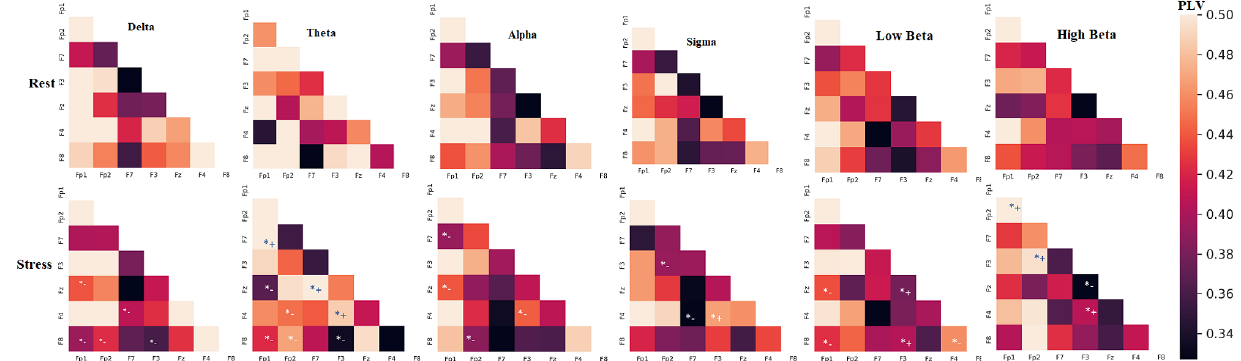
Figure 7. The PLV connectivity network among EEG channel pairs over all trails for rest and stress condition. The star (*) symbol denotes the significant connections between electrodes selected by the t